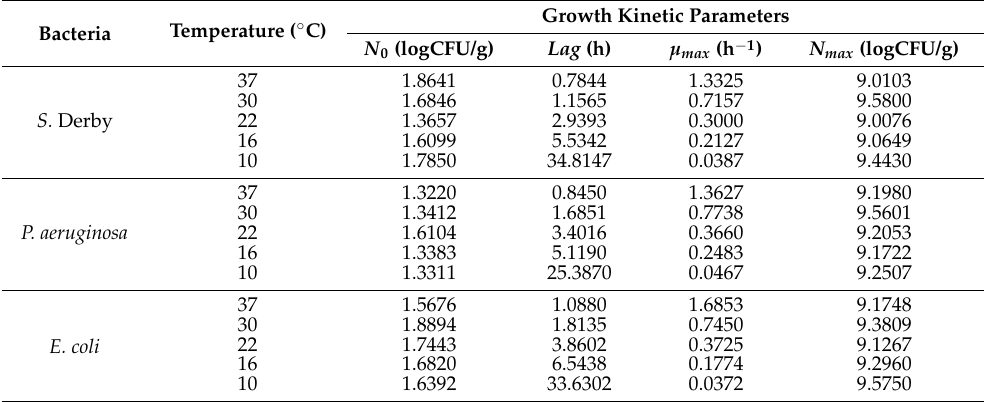
Table 2. Kinetic parameters of each bacterial optimal primary growth model in pork at different temperatures.